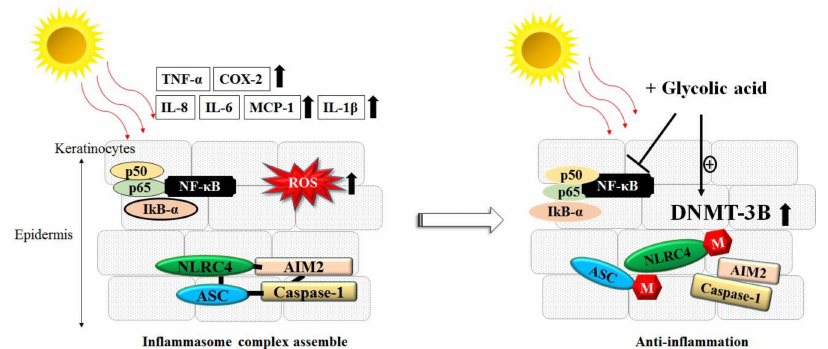
Figure 3. Glycolic acid (GA) had anti-inflammatory and photoprotective effects against UVB-irradiation in keratinocytes. ( Left ) UVB-irradiation activated the nuclear factor-kappa B (NF-kB) pathway and promoted the inflammasome complex assembly, which in ROS accumulation and the release of several proinflammatory cytokines (e.g., interleukin (IL)-6, IL-8, monocyte chemoattractant protein (MCP)-1, IL-I β , COX-2, and IL-1 β ; ( Right ) Pretreatment with GA could activate DNMT-3B activity and induce the hypermethylation of promoters of NLRC4 and ASC genes, which subsequently hinder of the assembly of the inflammasome complex. GA also inhibited the UVB-induced promoter activity of NF-kB in keratinocyte